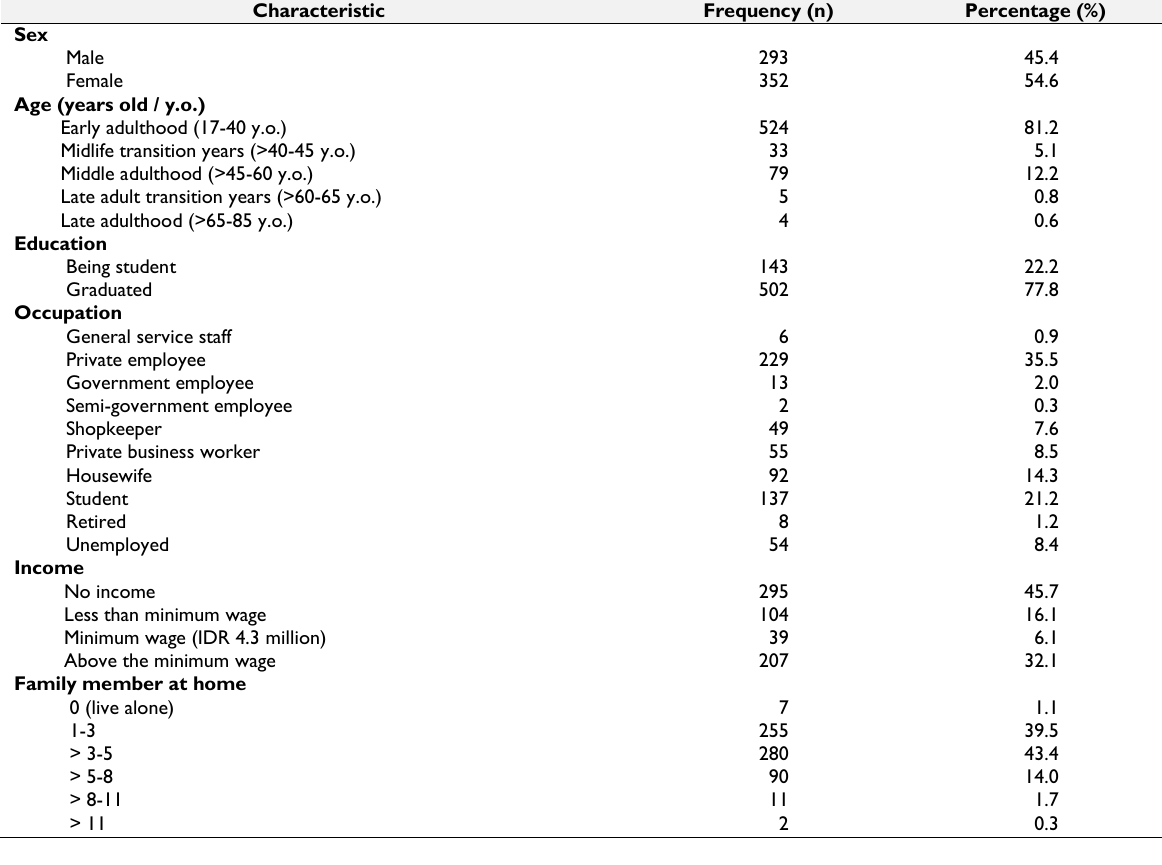
Table 1 Demographic characteristics of the respondents Characteristic